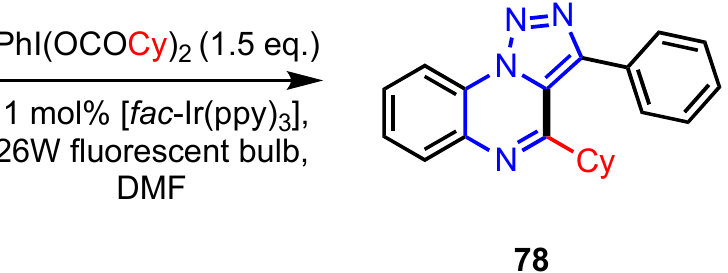
Scheme 20. Photoredox approach for the synthesis of a 1,2,3-triazoloquinoxaline 78 . (Cy = cyclohexyl, fac = facial, ppy =